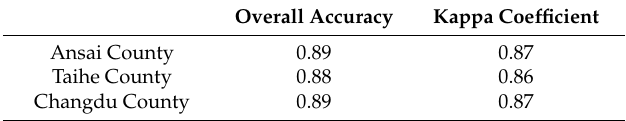
Table 6. Accuracy assessment of the classification results for Ansai, Taihe, and